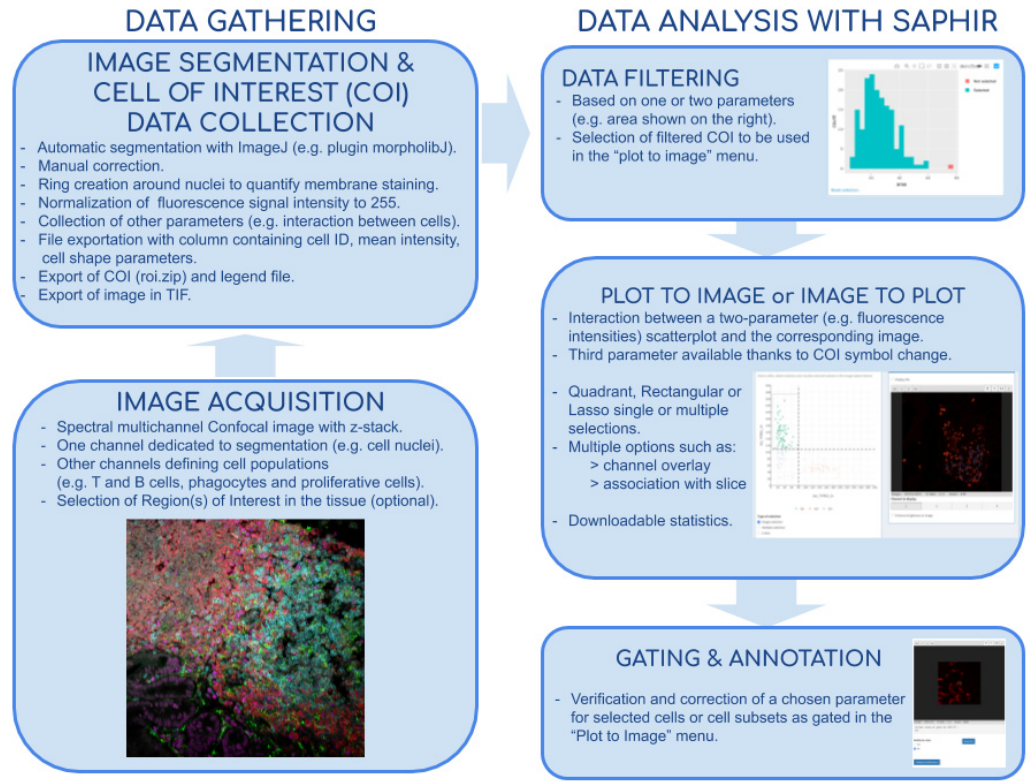
Figure 1. Flow chart of tissue image analysis from image acquisition and segmentation (left side) to extracted data analysis with SAPHIR (right